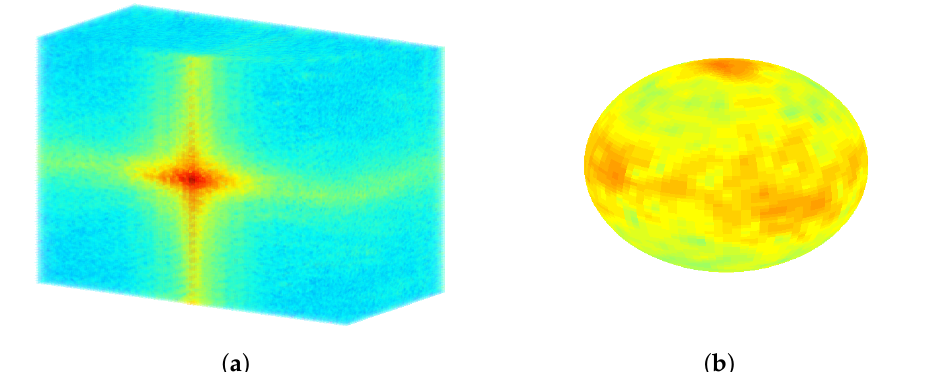
Figure 1. The three dimensional (3D) frequency representation of scan data. The entire assembly of the transformation parameters are based on 3D spectral information. Only the basic shape of the small carpal bones remains the same between different scans. An according basic structure is solely represented by 3D low frequencies from the spectral point of view. ( a ) Sectional view of a full 3D spectrum. The low frequencies in the center contain most of the energy and have a major contribution to clearly visible structures of objects. ( b ) Low frequencies used for the registration = 0.2 π process. The spherical spectral structures are resampled up to f c u , v , w